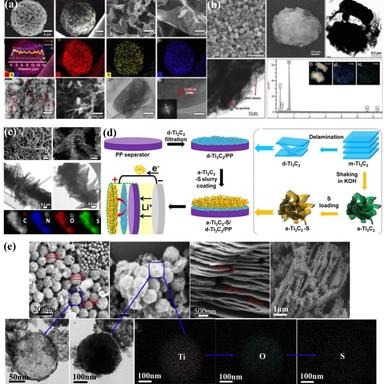
(a)FE-SEM and TEM images of the R-rGO/nS. Medium- andhigh-magnification FE-SEM images. Overlay image containing C, S, and O element profiles of the corresponding STEM image along the horizontal lines. Individual element STEM mapping images. HR- and dark-field TEM images of rod-shaped nS crystals on the RrGO/nS surface. High-magnification HR-TEM images of the Ns Copyright 2019, American Chemical Society; (b) Morphological characteristics of G-SeHMs: Low- and high-magnification SEM images. Low-